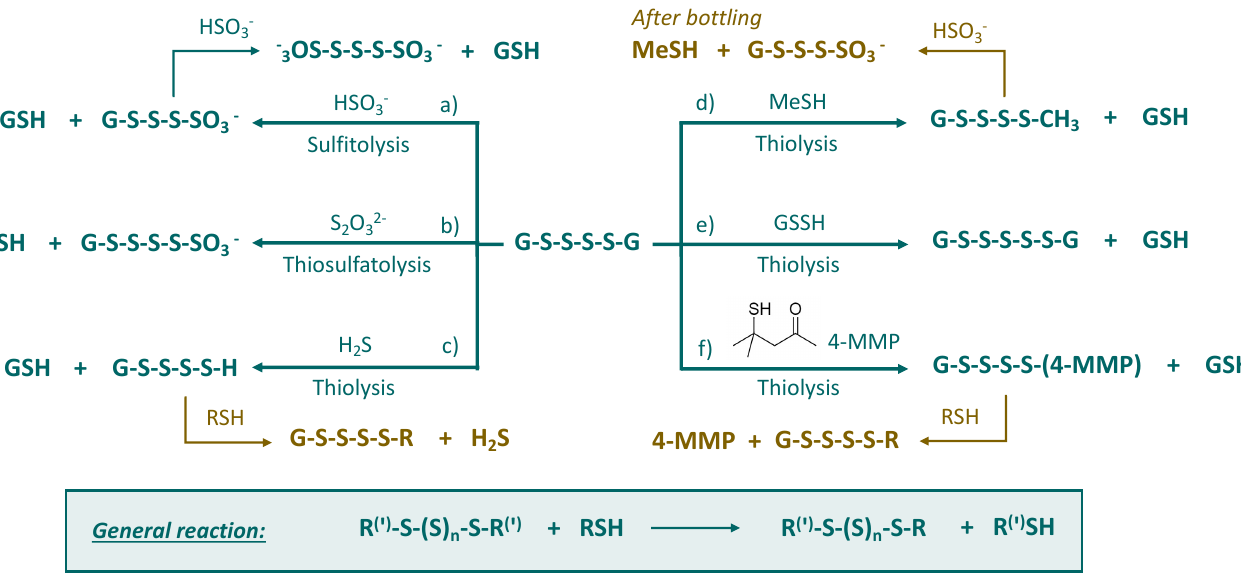
Figure 5. Suggested reactions of diglutathionyl tetrasulfide with S-nucleophiles in wine: examples of chemical transformations for Figure 2, the part colored